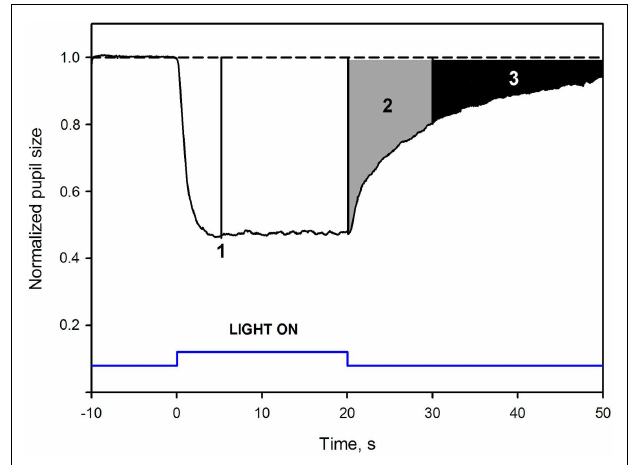
FIGURE 1 | Mean pupil response to blue 300cd/m 2 light in healthy subjects: pupil response parameters .The dotted line at the top is an extrapolation from baseline pupil size.The Y -axis represents values of the normalized pupil size (NPS). On the X -axis, time − 10 is the start of pupil video recording while in darkness.Time 0 is the onset of a 20s, continuous, blue light stimulus (vertical bars at the bottom). Point 1 shows where the maximal contraction occurs (the maximal CA).The second parameter, 2, is the early post-illumination AUC (gray shaded area in the pupillogram), which is the summed pupil response amplitudes over 10s after light termination. The late post-illumination AUC, 3 (black shaded area), another summed response parameter from 10th to 30th second after light termination. For parameter definitions, Section “Materials and